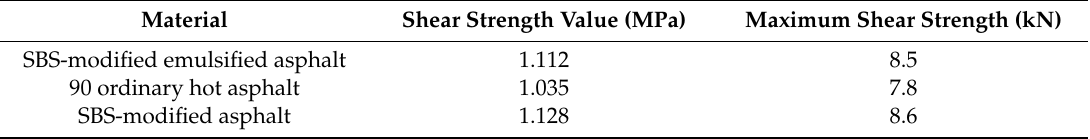
Table 8. Shear strength of the waterproof cohesive layer in di ff erent interlayer bonding states. Material Shear Strength Value